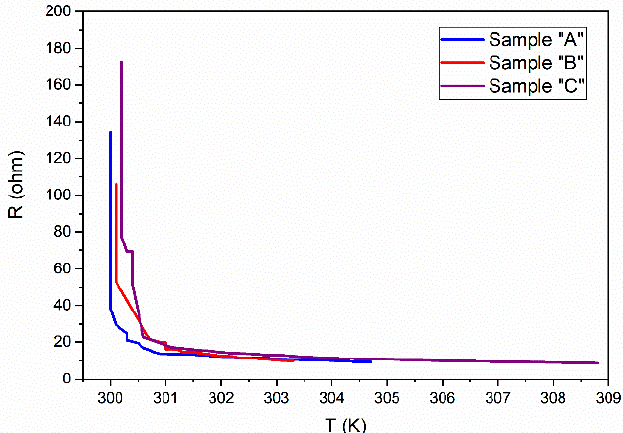
Figure 8. Resistance deviation with respect to the generated temperature of the CNP-based electro-thermal device with graphite electrodes.